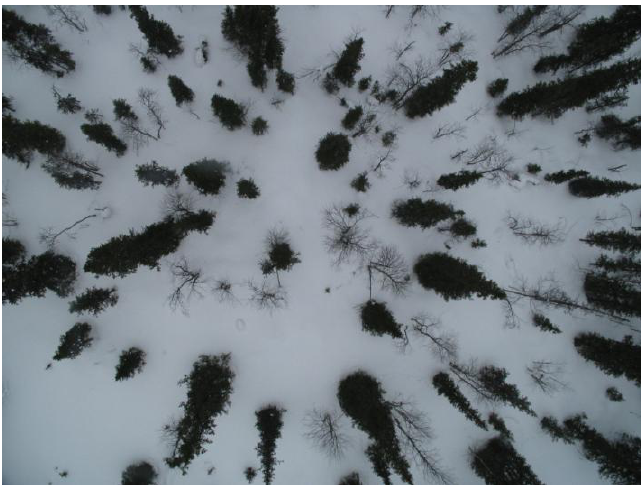
Figure 10. LAI is underestimated in forests with large percentage of deciduous